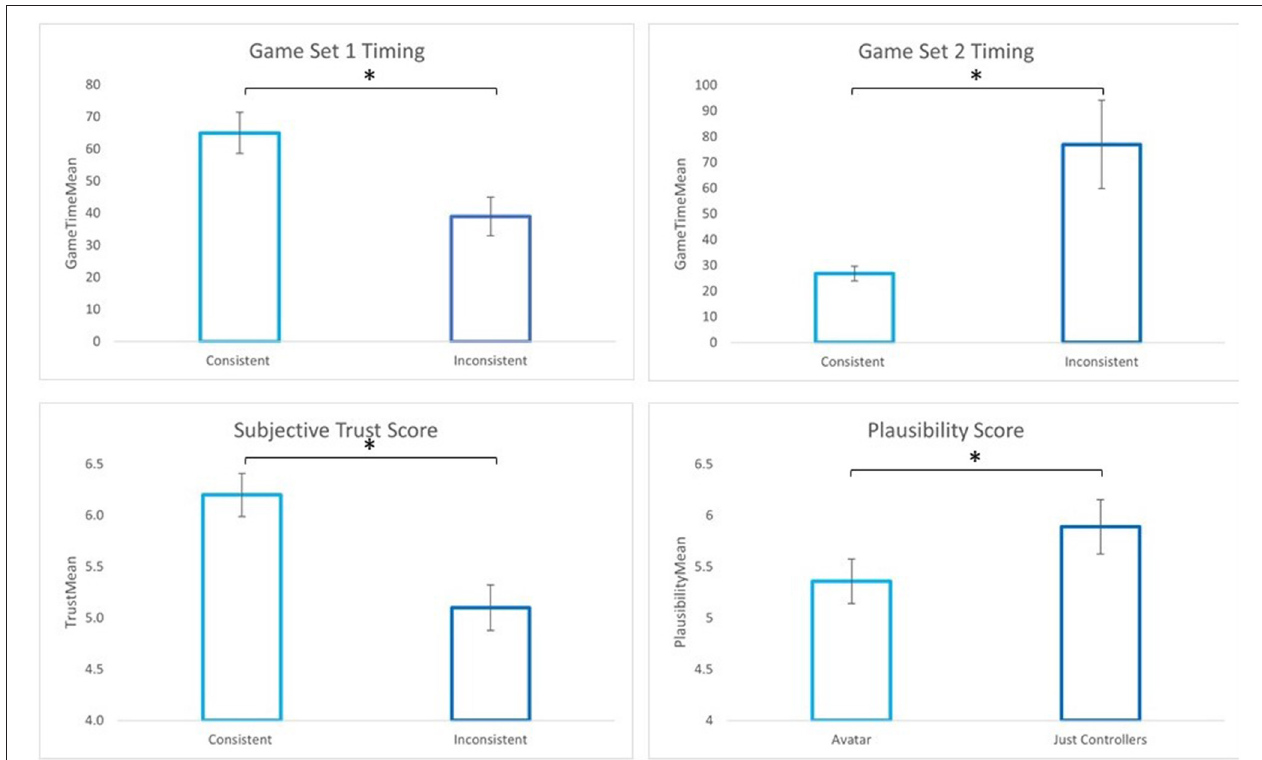
FIGURE 10 | Study 2: (Top Line) bar chart of game set 1 and 2 timings, comparing consistent and inconsistent conditions. (Bottom Line Left) bar chart of subjective trust, comparing consistent and inconsistent conditions, and (Bottom Line Right) bar chart of plausibility illusion score, comparing conditions where the other participant was with or without an avatar. * p <